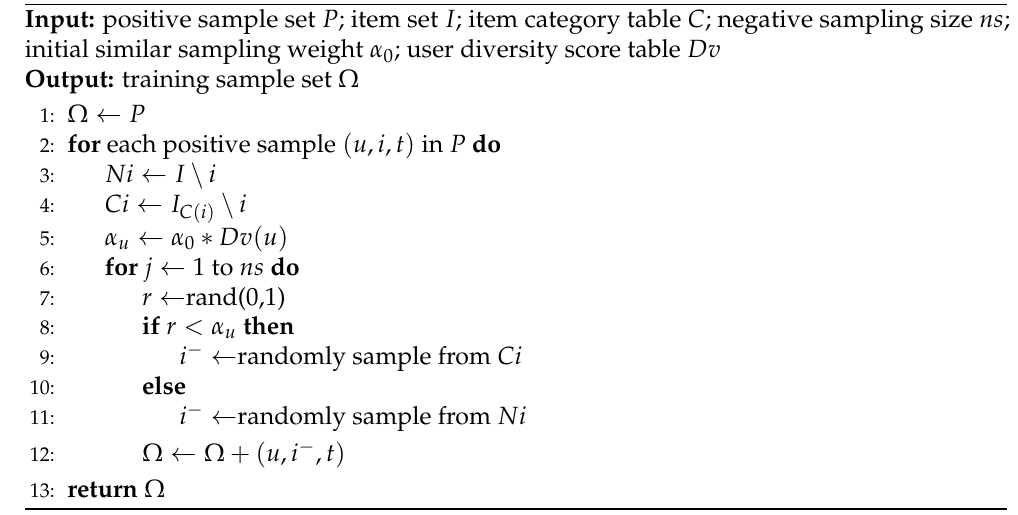
Algorithm 1 Personalized category-boosted negative